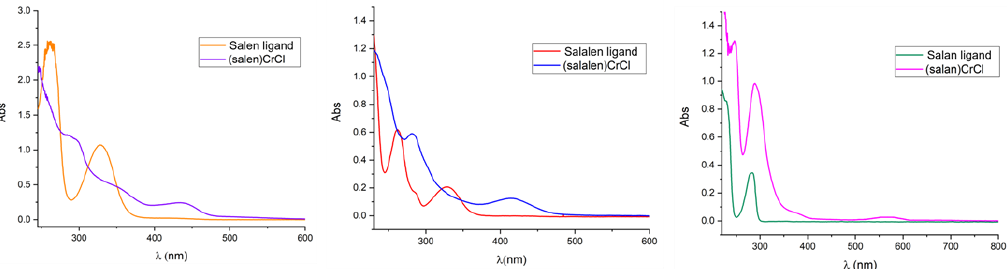
Figure 1. Electronic absorption spectra of complexes 1 – 3 and the related ligands in acetonitrile.